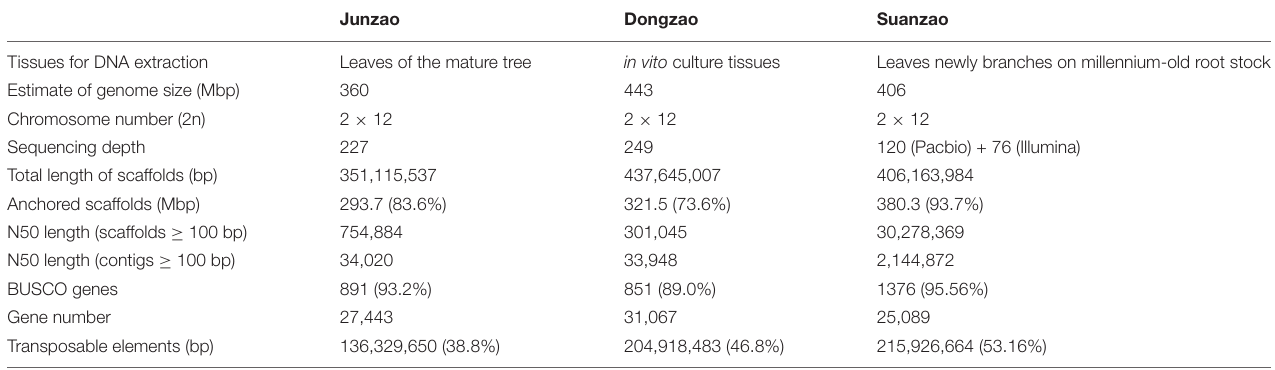
TABLE 1 | Comparison of three jujube genome assemblies.